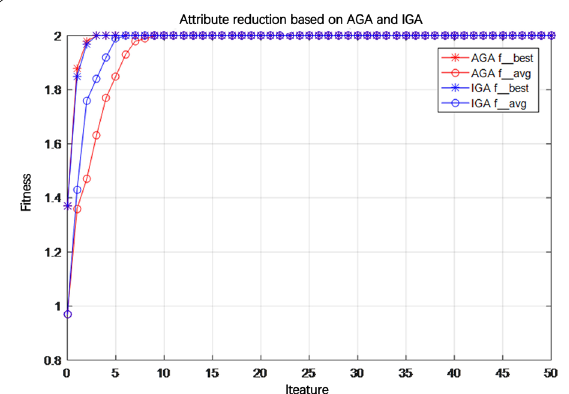
in the current population represents the optimal solu- tion. The adaptive genetic algorithm and improved genetic algorithm were used for attribute reduction and the iterative process is illustrated in Figure 4. In Figure 4, the red “*” curve represents the optimal value searching iteration process of the adaptive genetic algorithm. The red “o” curve represents the average value obtained by searching through the iteration process of the adaptive genetic algorithm. The blue “*” curve rep- resents the optimal value searching iteration process of the improved genetic algorithm. The blue “o” curve rep - resents the average value searching iteration process of the improved genetic algorithm. As shown in Figure 4, in terms of optimal value optimization, the results of the two algorithms are approximately the same, and